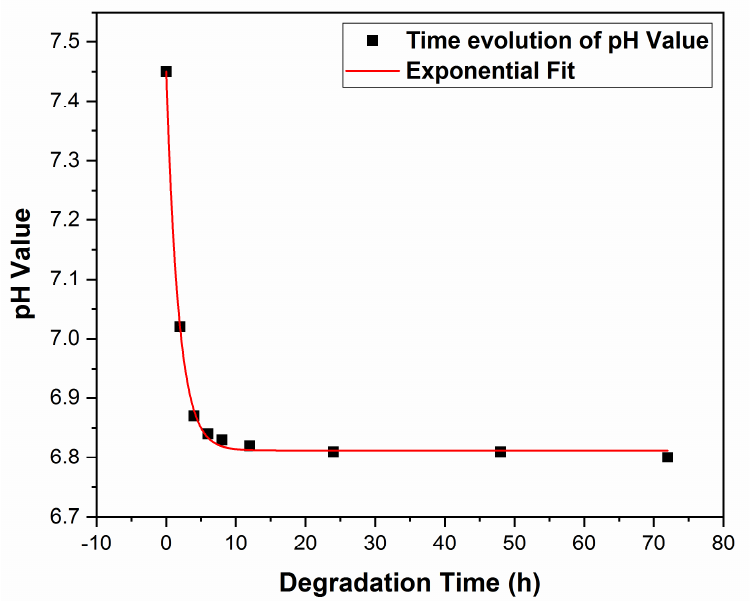
Figure 11. pH evolution with immersion time in SBF.